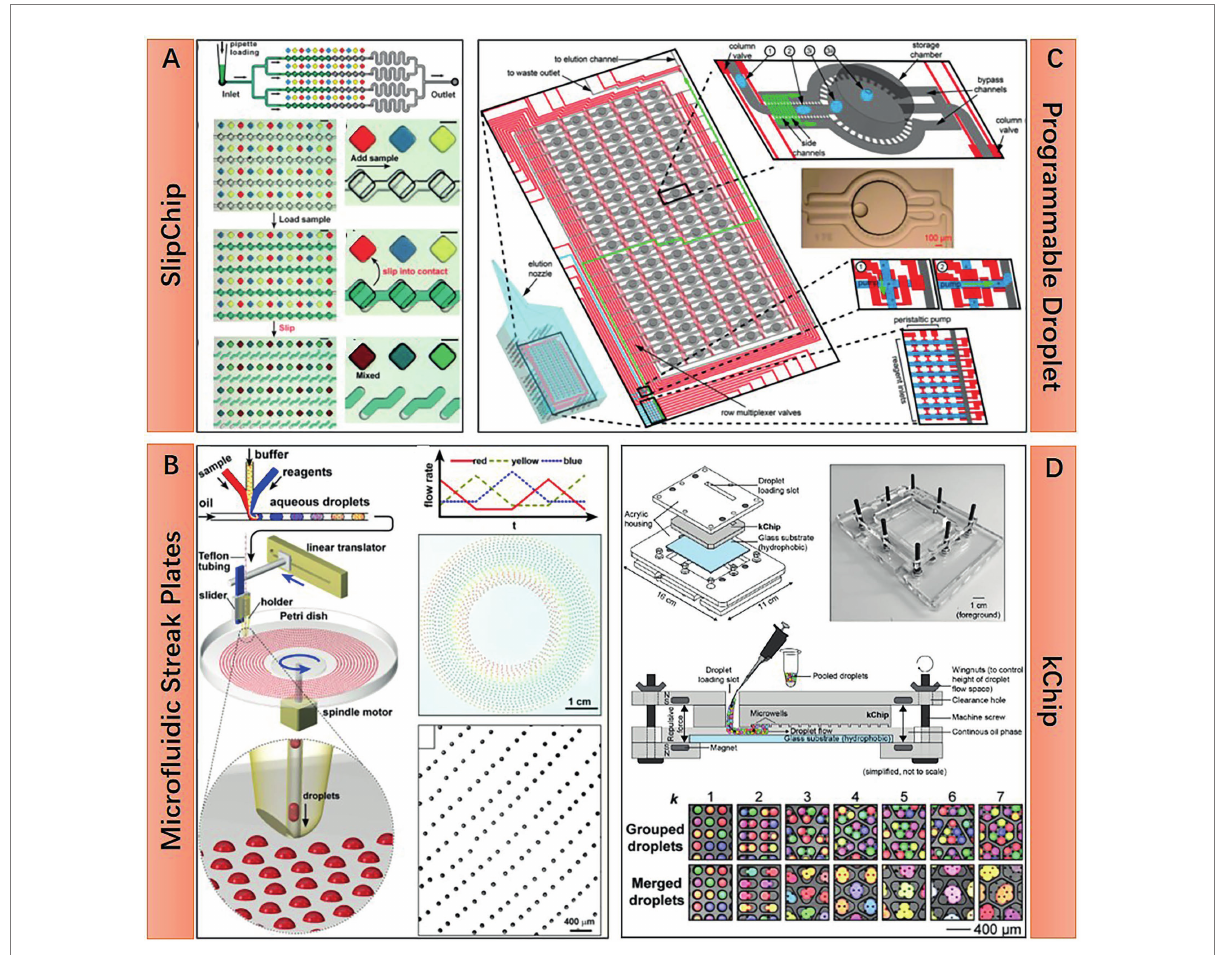
FIGURE 2 Structural features and working principle of diverse static droplet microfluidic approaches. (A) SlipChip approach, preloaded 48 droplet samples can be repeatedly manipulated in parallel by two simple steps operation, sample loading and chip slipping (Reprinted from Du et al., 2009 with the permission of Royal Society of Chemistry); (B) Microfluidic streak plates (MSP) approach, on-chip generated droplets are streaked on Petri dish to form sessile droplet array, one Petri dish can hold 1,600 droplets with 6.2 nl volume (Reprinted from Jiang et al., 2016 with the permission of American Society for Microbiology); (C) Programmable droplet microfluidic approach, in each of the 95 storage chambers, droplet immobilization and coalescence are realized by flow-controlled wetting, flow control is realized by programmable quake valve operations (Reprinted from